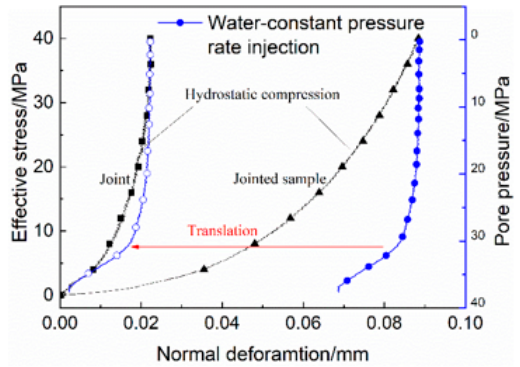
Figure 8. The relative normal deformation of jointed sample during the water injected in constant pressure rate injection.